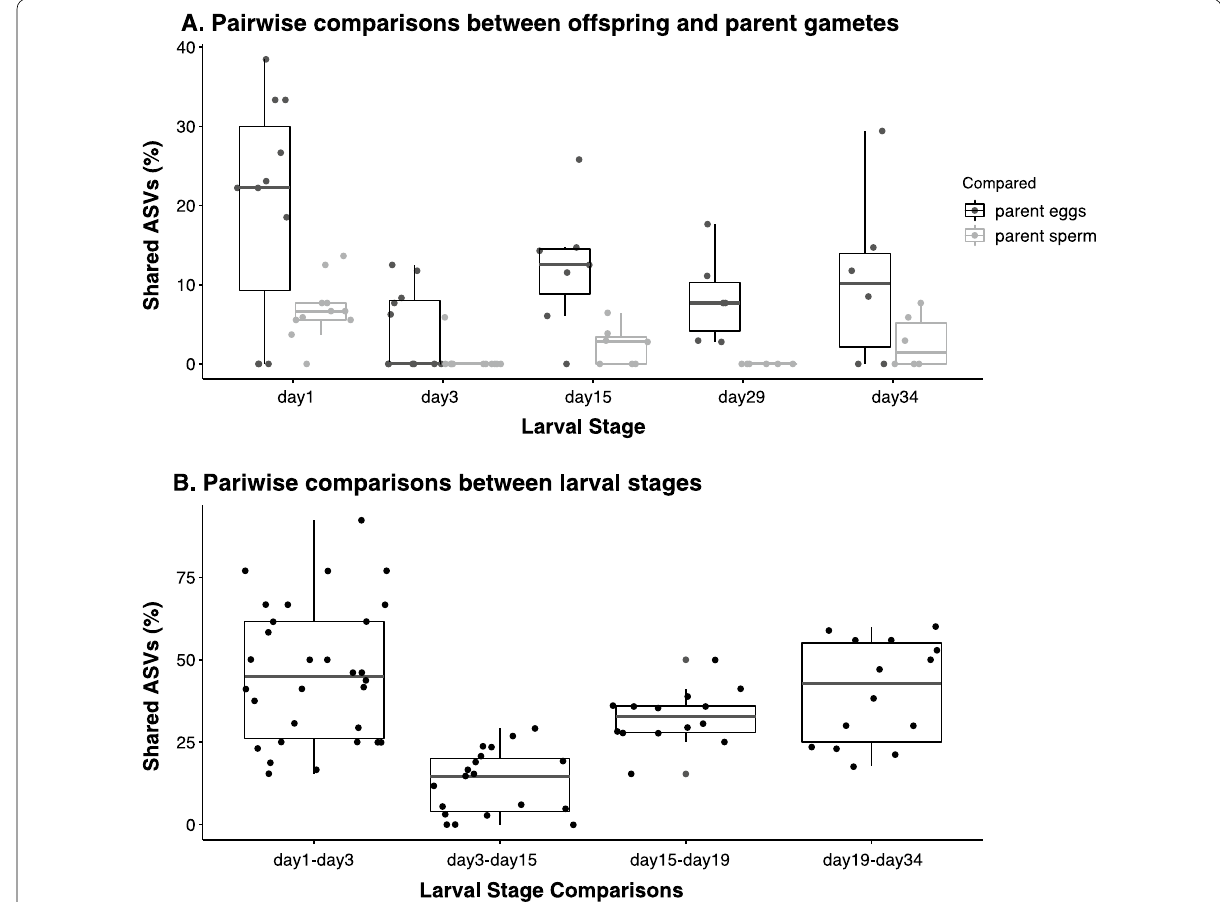
Fig. 6 Box and whiskers plots of the percentage of ASVs shared A between each larval stage and their parent eggs and sperm, and B between adjacent larval stages. This analysis excluded all ASVs detected in tank water and algae samples with a relative abundance greater than